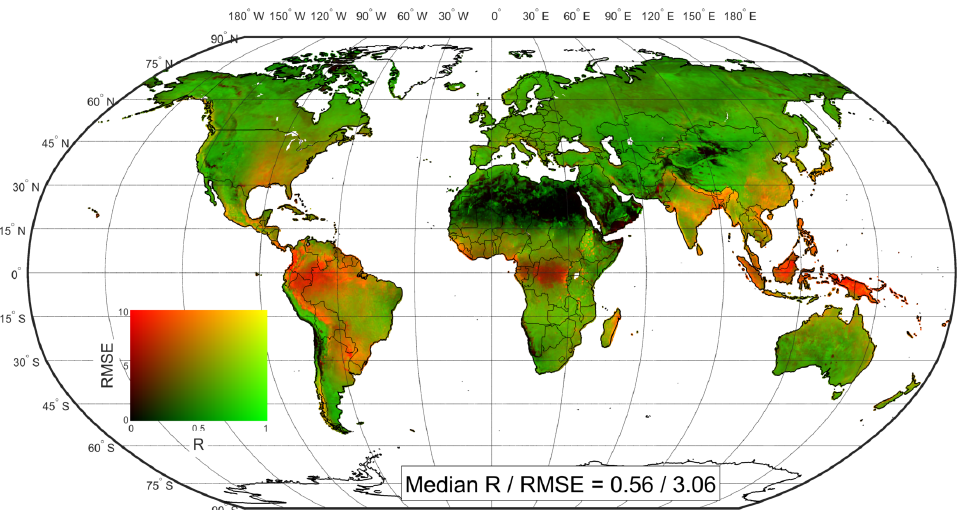
Figure 5. Pearson’s correlation, R , and root mean square error, RMSE, map of the SM2RAIN–ASCAT data record compared with the ERA5 reanalysis dataset used as a benchmark (period 2007–2018). The analysis is carried out at a 1d and 12.5km temporal and spatial resolution. The map shows that the SM2RAIN–ASCAT data record is performing well in the western United States, Brazil, southern and western South America, southern Africa, the Sahel, southern central Eurasia, and Australia (green